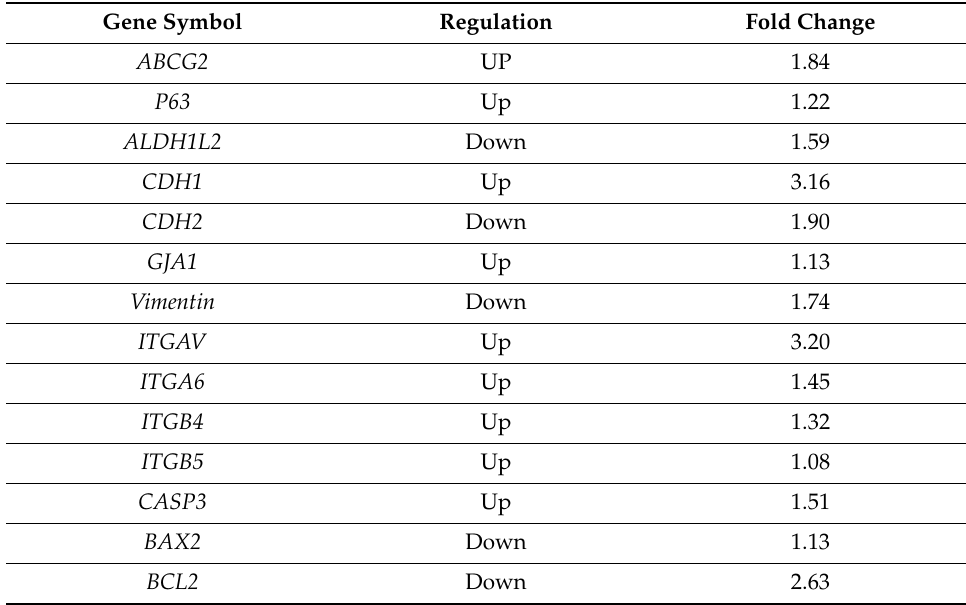
Table 4. The gene expression data as fold change in a 3-week culture of OMECs on 3-HAC4 compared to control OMEC sheets grown on collagen IV-coated plastic. Gene Symbol Regulation Fold